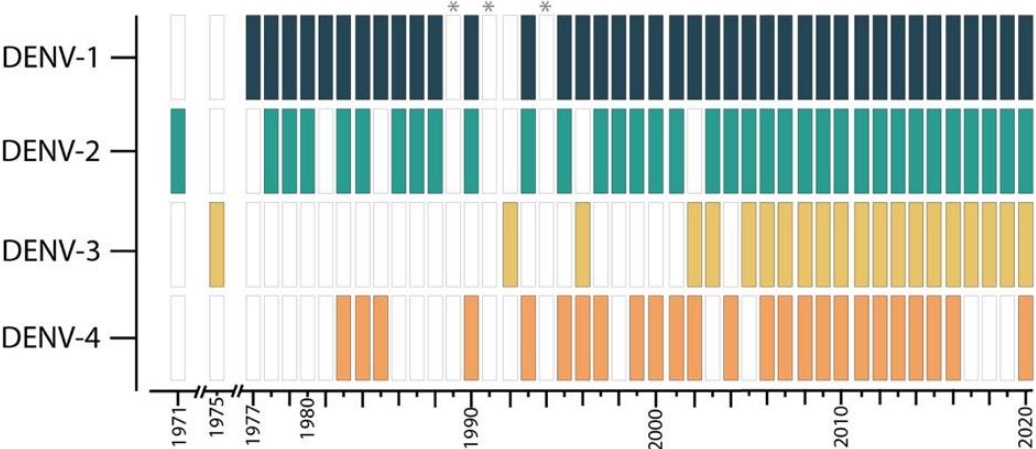
Figure 5. Presence of circulation of Dengue serotypes in Colombia from 1971 to 2020. * No data available [13,35].